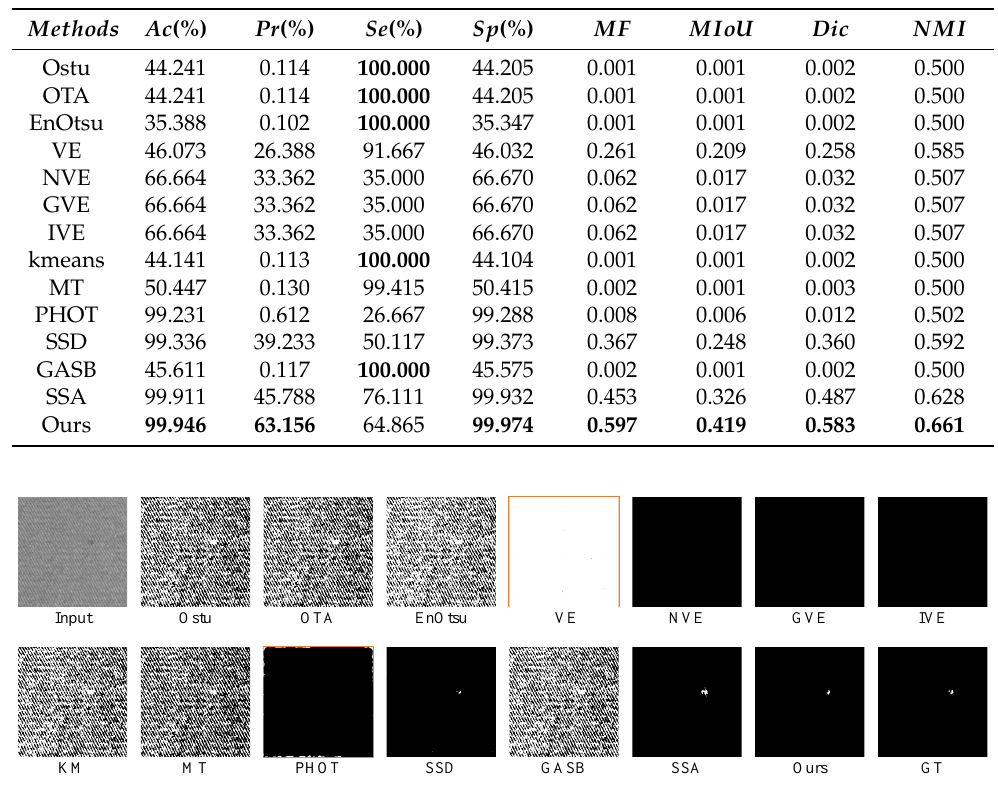
Figure 9. Visual comparisons of detection results of the fourteen methods on fabric images. SSD, SSA, and the proposed method (ours) are capable of identifying the defect